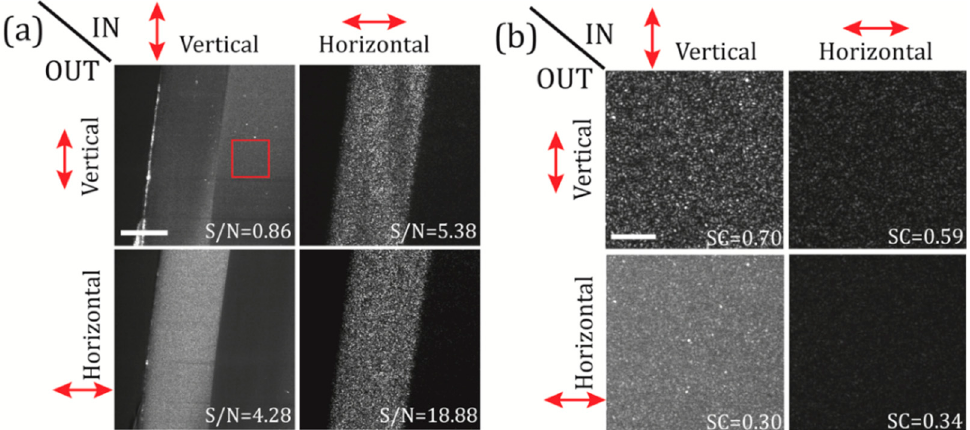
Figure 2. Polarization filtering on a test sample made of a fluorinated ethylene propylene (FEP) tube containing 1% agarose. In ( a ) the FEP-tube wall is imaged changing the polarization state (vertical or horizontal) of the illumination beam (IN), and, selecting the polarization (vertical or horizontal) at the detection path (OUT). The S/N ratio is calculated for the four IN-OUT polarization combinations, as the ratio of the mean intensities of the FEP to the agarose regions. Scale bar 100 μ m. In ( b ) the speckle patterns of selected regions-of-interest on the agarose (red square in panel (a)) are shown for the four available polarization configurations. Speckle contrast (SC) is also shown for all configurations; see the main text for details. Scale bar 15 μ m. Laser power at the back of OBJill is 6 mW.